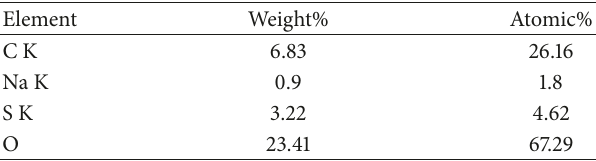
Table 1: Different elements like carbon, sodium, sulfur, and oxygen present in MWCNT-PEDOT:PSS